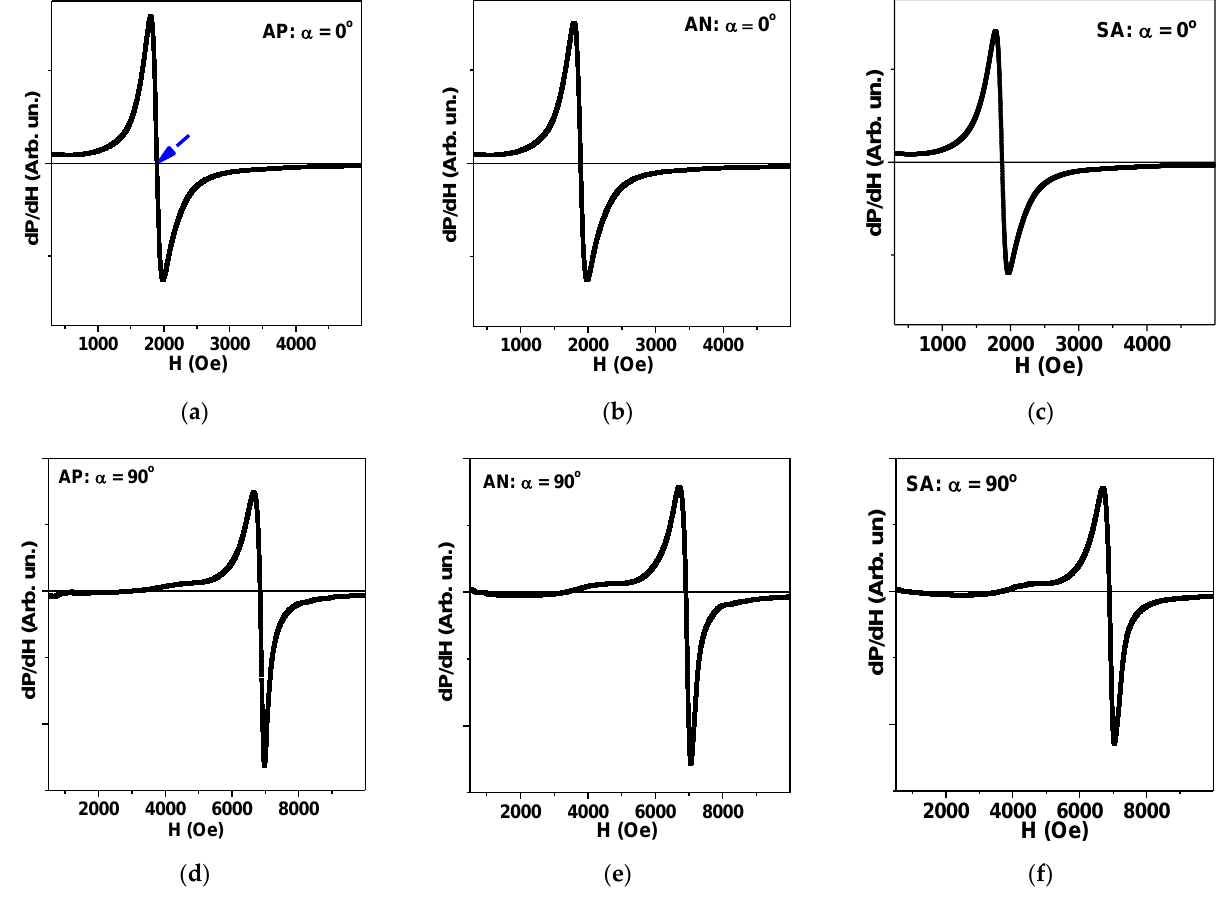
Figure 7. ( a – c ) Ferromagnetic resonance curves dP/dH of Fe 3 Co 67 Cr 3 Si 15 B 12 amorphous ribbons in the different states AP, AN and AP measured in-plane, respectively, with α = 0 °; and ( d – f ) out-of- plane of the samples , respectively, with α = 90° . Blue arrow ( a ) indicates the orientation of the FMR resonance field (H res ) definition. All measurements were done for the microwave frequency f = 9.39 GHz and at room temperature.